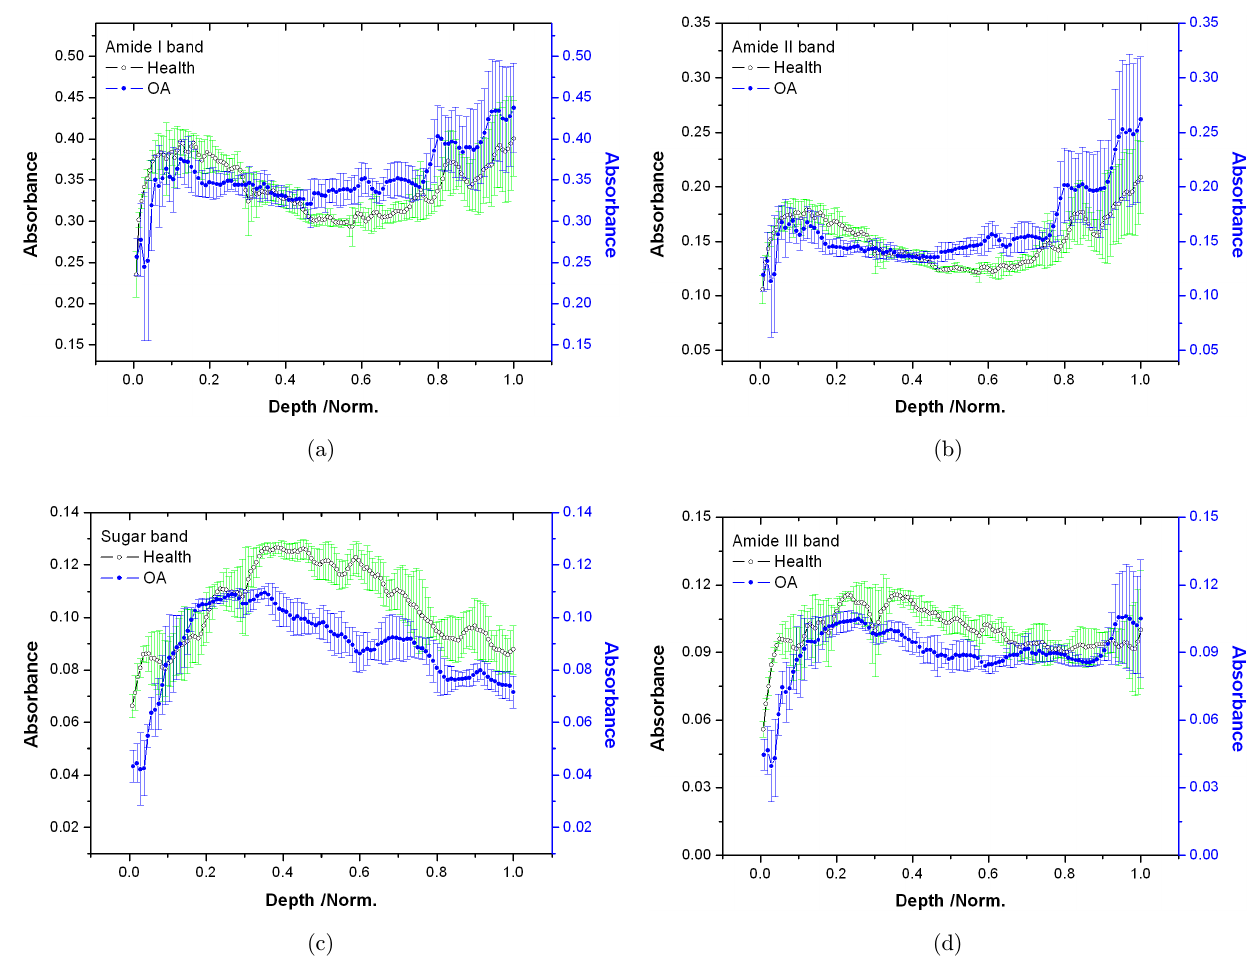
Fig. 4. The comparisons of the absorption intensity pro¯les of (a) amide I, (b) amide II, (c) sugar and (d) amide III across the entire depths of the healthy and osteoarthritic cartilage sections. The absorption values are represented by using the hollow and solid circles for the healthy and osteoarthritic samples, respectively. The error bar implies the standard deviation of the